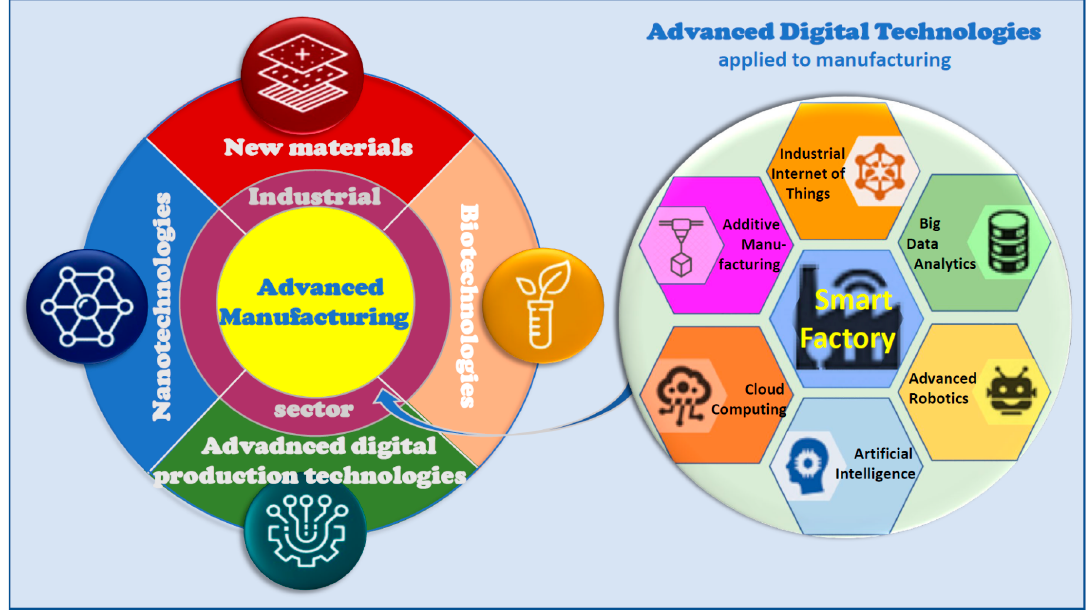
Figure 2. Diagram of advanced digital production and advanced technologies applied to manufacturing